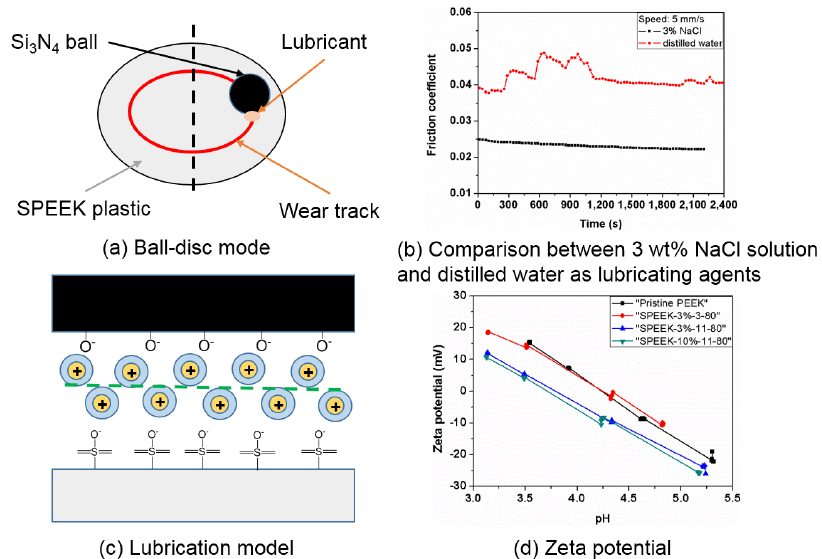
Fig. 5 Surface charges of SPEEK and their influence on friction. (a) Schematic of the friction test setup; (b) friction coefficients between Si 3 N 4 ball and sulfonated PEEK disc obtained using distilled water and 3 wt% NaCl solution; (c) model of the hydration lubrication; and (d) zeta potential of the pristine PEEK and SPEEK discs at different pH. The negatively charged groups on the SPEEK sample adsorb hydrated Na + cations to separate the asperities of the two friction